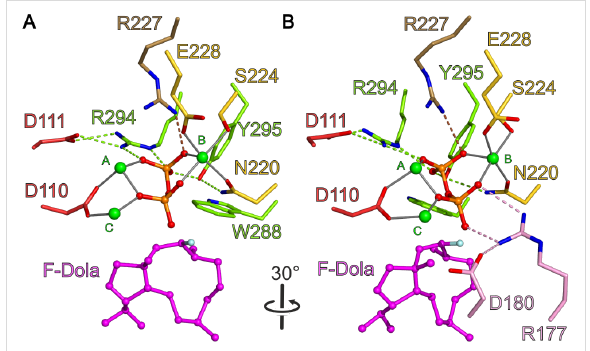
Figure 5: View into the active site of CotB2 wt ·Mg 2+ 3 ·F-Dola [37]. Iden- tical view as in Figure 4. (A) The bound F-Dola reaction intermediate is shown in magenta with the fluorine atom colored in light blue, and Mg 2+ -ions are shown in green. Residues of the DDXD motif are shown in red and residues of the NSE motif in yellow. The conserved residues of the WXXXXXRY motif are drawn in light green and the R227 that interacts with diphosphate moiety in light brown. The cleaved diphos- phate is shown in orange. Hydrogen bonds and salt bridges are indi- cated by dashed lines in the same color-coding as the involved motifs. Gray lines represent the coordination sphere of the Mg 2+ -ions. For clarity water molecules have been omitted. (B) View in panel A rotated by 30°. In addition to the motifs shown in panel A, the pyrophosphate sensor motif is depicted in